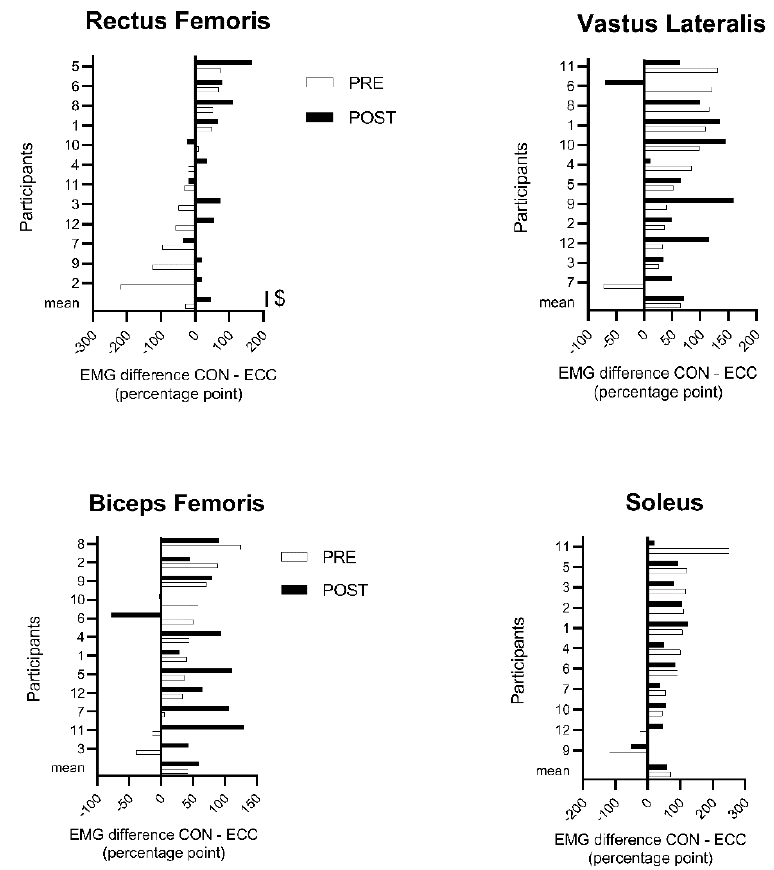
Figure 2. Individual di ff erence in EMG between concentric and eccentric cycling. This figure shows the di ff erence (percentage point) in the root mean square of the EMG between CON and ECC cycling, averaged for all exercise intensities per muscle and per individual, before (PRE) and after (POST) the four sessions of cycling. Note that the scale of the abscissa di ff ers for each chart. A negative score means that EMG RMS was greater in ECC than CON cycling. $ : Di ff erence between PRE and POST at a given power output ( p < 0.05). Error bars represent the standard